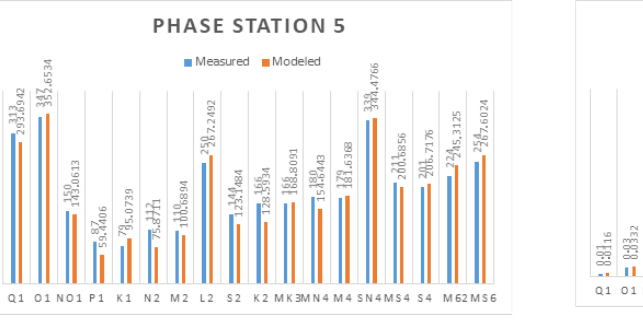
Table 2. Modeled salinity with different estimated SGD inputs and observed in the three transects of the lagoon and root mean square error RMSE for each.